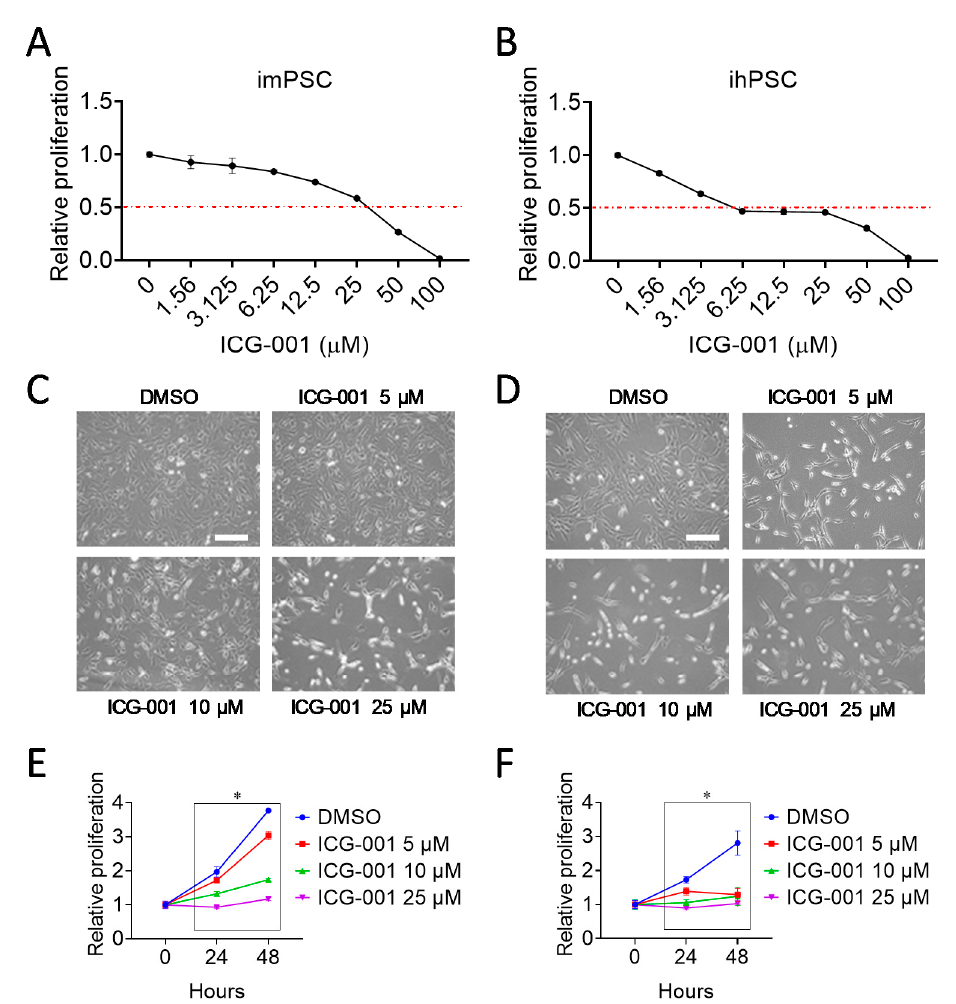
Figure 1. Cyclic AMP-response element binding protein-binding protein (CBP) / β -catenin antagonism suppresses proliferation of pancreatic stellate cells. E ff ect of CBP / β -catenin antagonist ICG-001 versus control (DMSO) treatment for 48 h on proliferation of immortalized mouse pancreatic stellate cells (imPSC) ( A ) and immortalized human pancreatic stellate cells (ihPSC) ( B ) as assessed by CellTiter-Glo assay. imPSC, immortalized mouse pancreatic stellate cells; ihPSC, immortalized human pancreatic stellate cells. E ff ect of ICG-001 treatment for 48 h on proliferation of imPSC ( C ) and ihPSC ( D ) as assessed by microscopy. Scale bar: 150 µ m. E ff ect of ICG-001 treatment for 24 h and 48 h on proliferation of imPSC ( E ) and ihPSC ( F ) as assessed by cell counting. n = 3, * p < 0.05 when each ICG-001 group compared to control (DMSO) at respective time point.